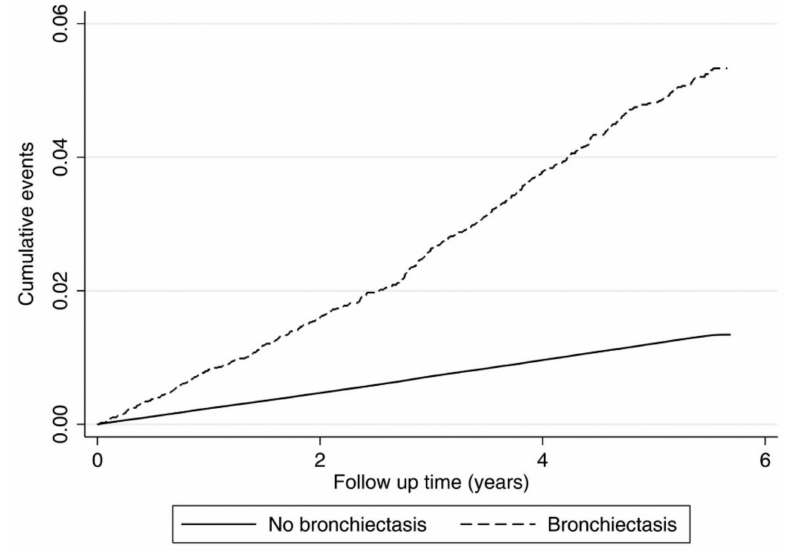
Figure 1. Nelson-Aalen cumulative incidence of stroke in people with bronchiectasis and those without bronchiectasis. Figure reproduced from